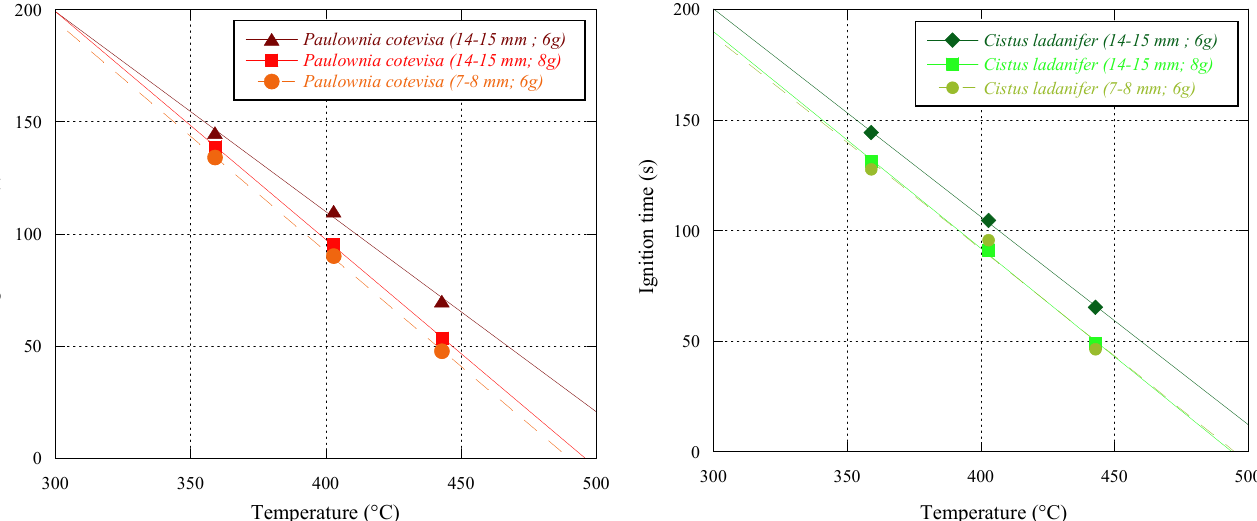
Table 6. Ignition time of Paulownia cotevisa and Cistus ladanifer pellets (s).